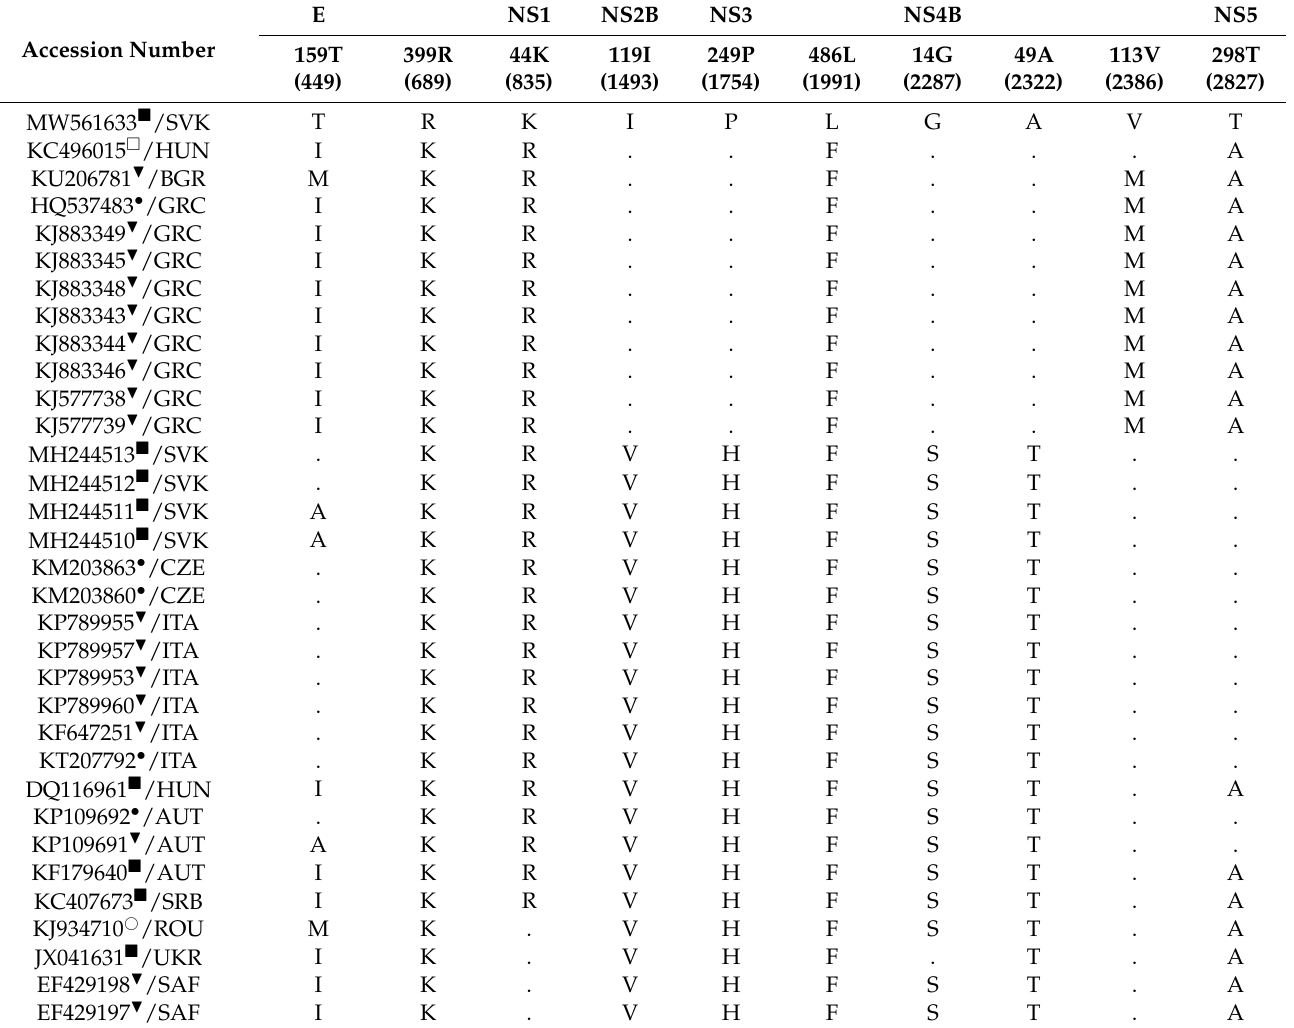
Table 1. Comparison and position of substitutions in the polyprotein of WNV lineage 2